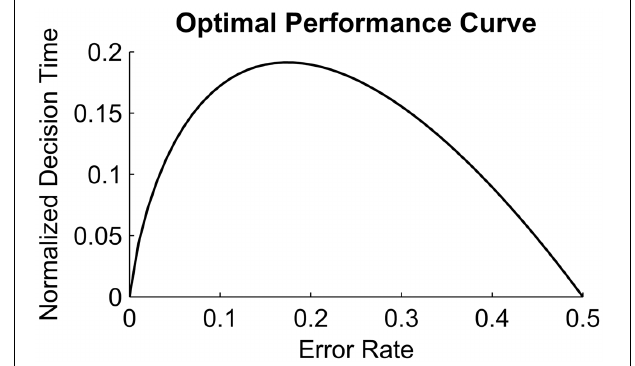
FIGURE 1 | Optimal Performance Curve derived from the pure Drift Diffusion Model. Horizontal axis shows ER and vertical axis shows the normalized decision time, i.e., Decision time divided by RSI + Ter; Reproduced from Bogacz et al. (2006).